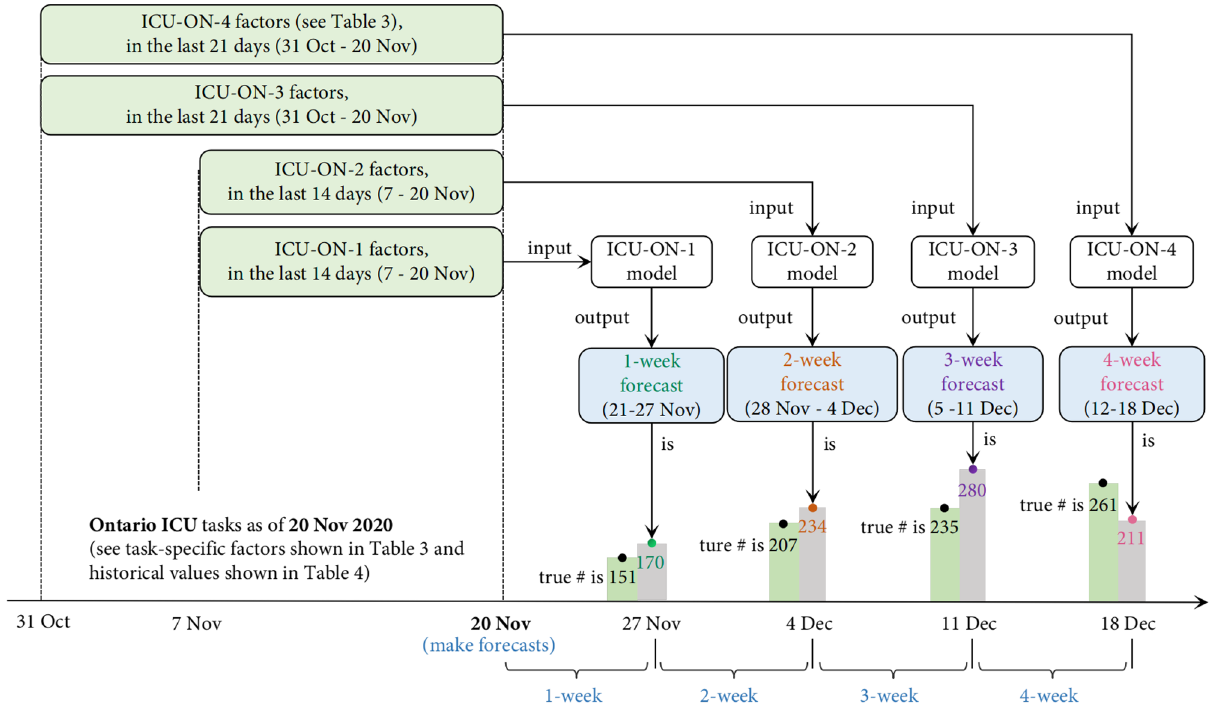
Figure 2. ICU-ON-1, ICU-ON-2, ICU-ON-3, and ICU-ON-4 forecasts, each made on 20 Nov